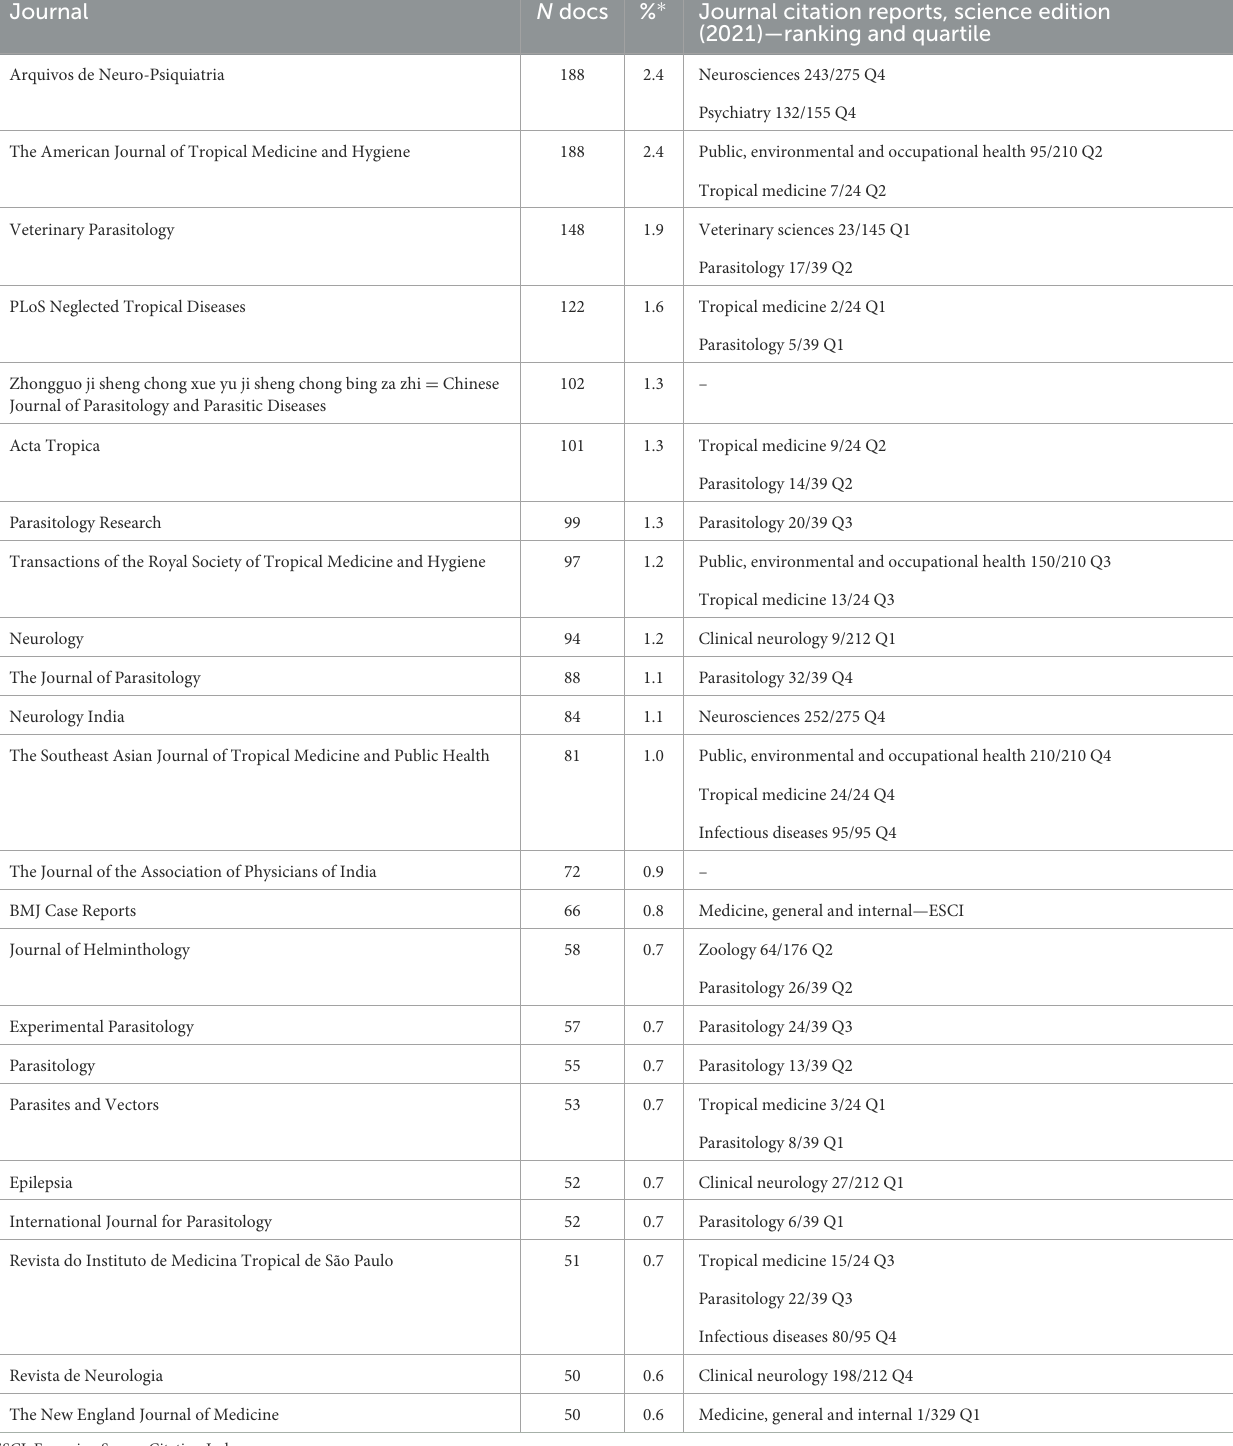
TABLE 2 Top journals publishing papers on cysticercosis and neurocysticercosis and indexed in MEDLINE. Journal N docs %